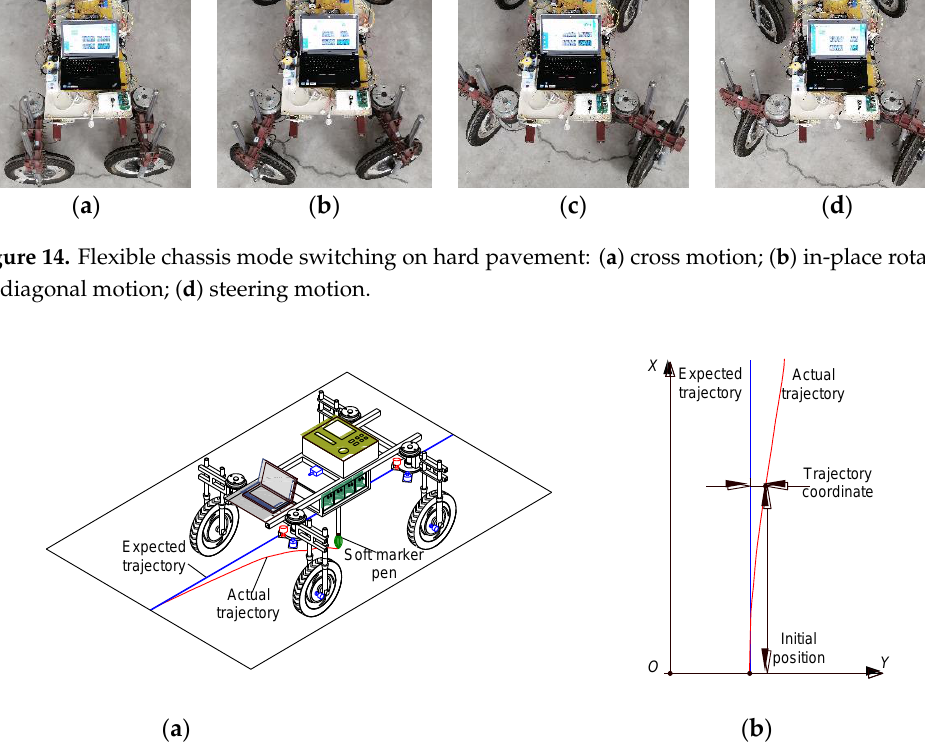
Figure 15. Schematic diagram of flexible chassis trajectory measurement: ( a ) method of measurement; ( b ) example of trajectory. Appl. Sci. 2020 , 10 , x FOR PEER REVIEW